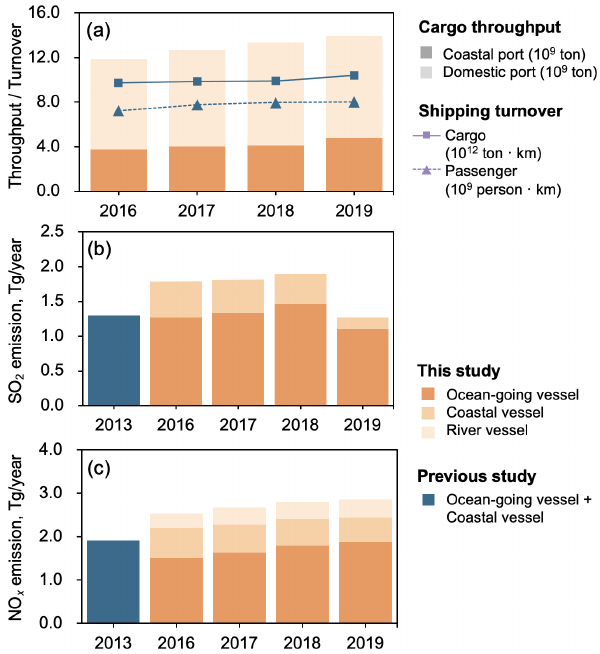
Figure 7. Annual changes in (a) seaborne trade and ship emissions of (b) SO 2 and (c) NO x from 2016 to 2019. Data in (a) are collected from the Chinese Statistical Yearbook (NBS, 2020). Emissions in 2013 are derived from our previous work for comparison (Fu et al.,